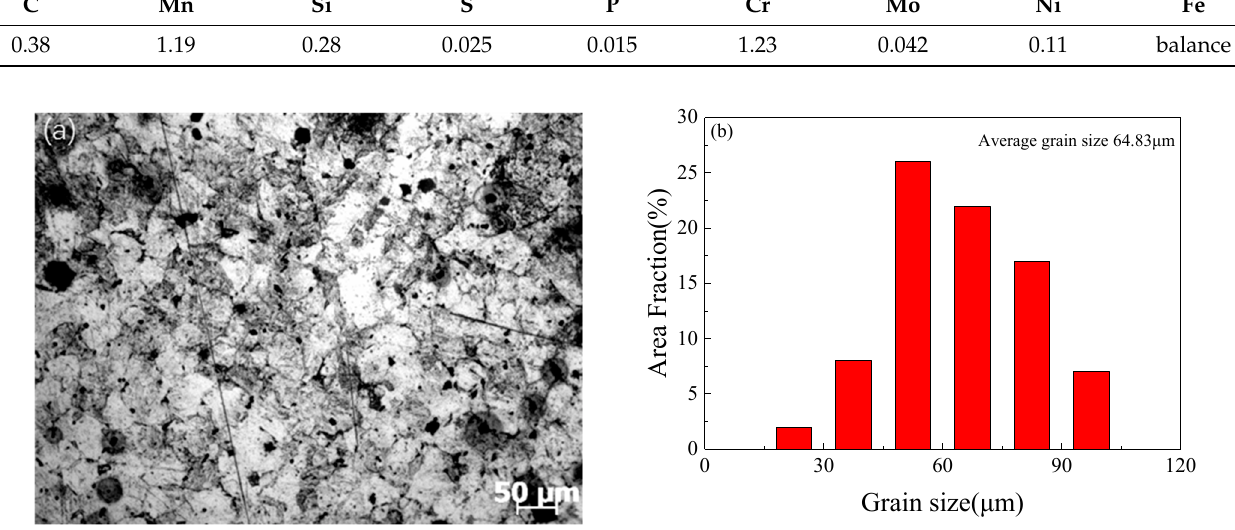
Figure 3. ( a ) Initial microstructure and ( b ) grain size distribution of the SAE 5137H steel. Table 1. Chemical compositions of SAE 5137H steel.